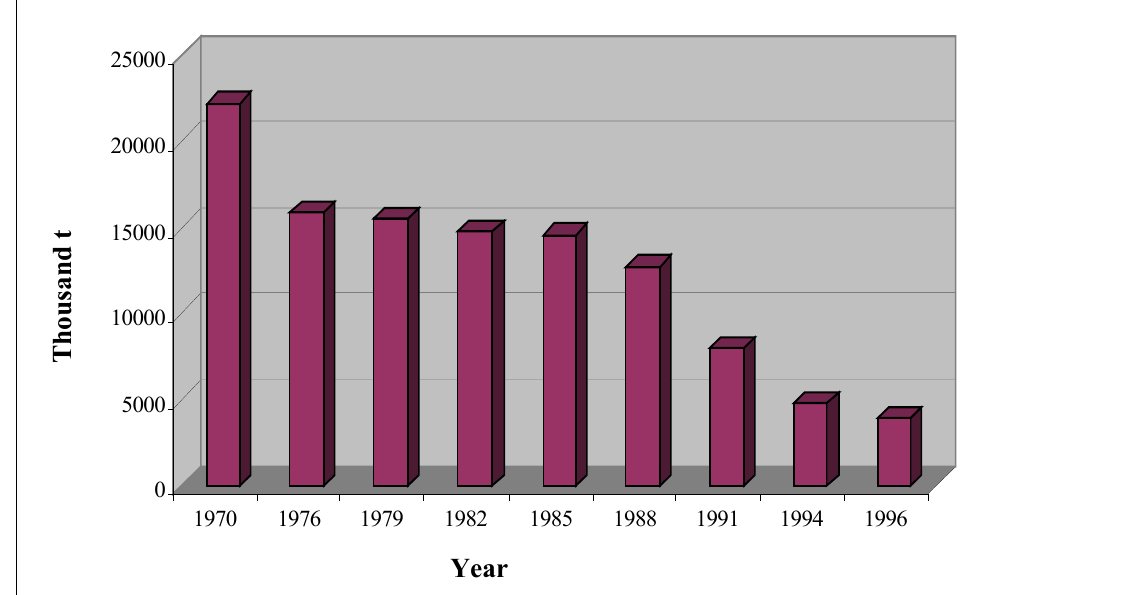
Figure 29: Development of the production of animal manure from animal husbandry